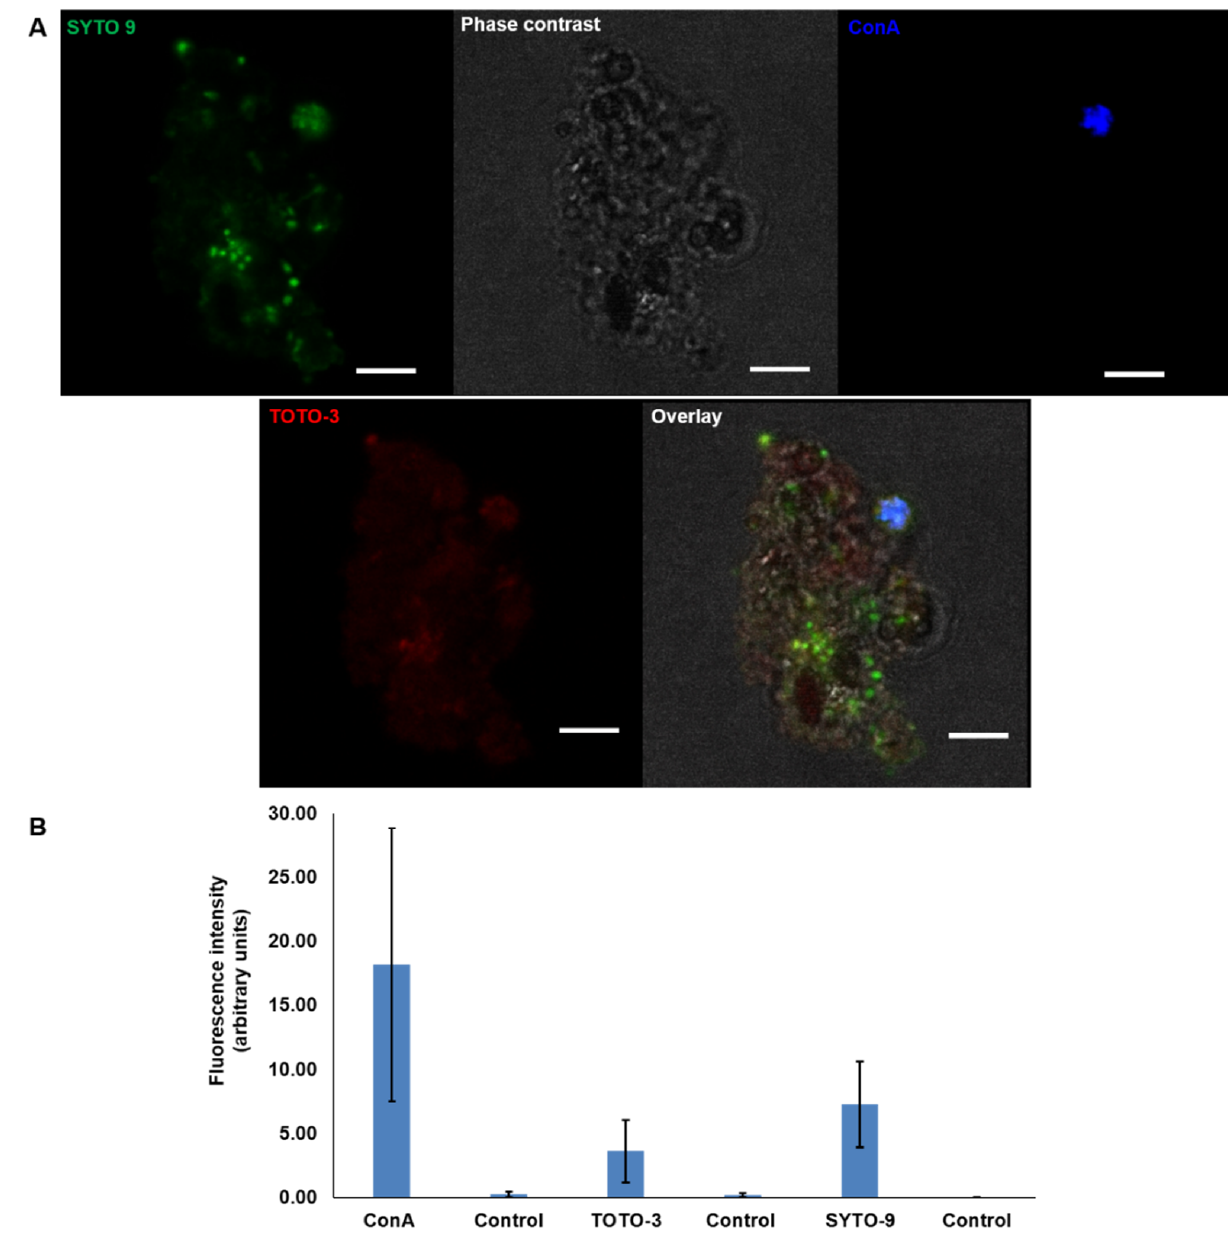
Figure 12. CLSM images acquired using Leica SP8 of P. atlantica EPS as MGP model stained for eDNA with TOTO-3 (red) and SYTO9 as counterstain (green), and ConA for glycoproteins (blue). Scale bar = 5 µ m ( A ). Quantification of the fluorescence intensity of each fluorophore revealed a high mean value. The control is unstained particles. The graphs present the mean ± SD of 15 CLSM micrographs. Error bars represent the standard deviation of the data set ( n = 3), p < 0.05 ( B ).